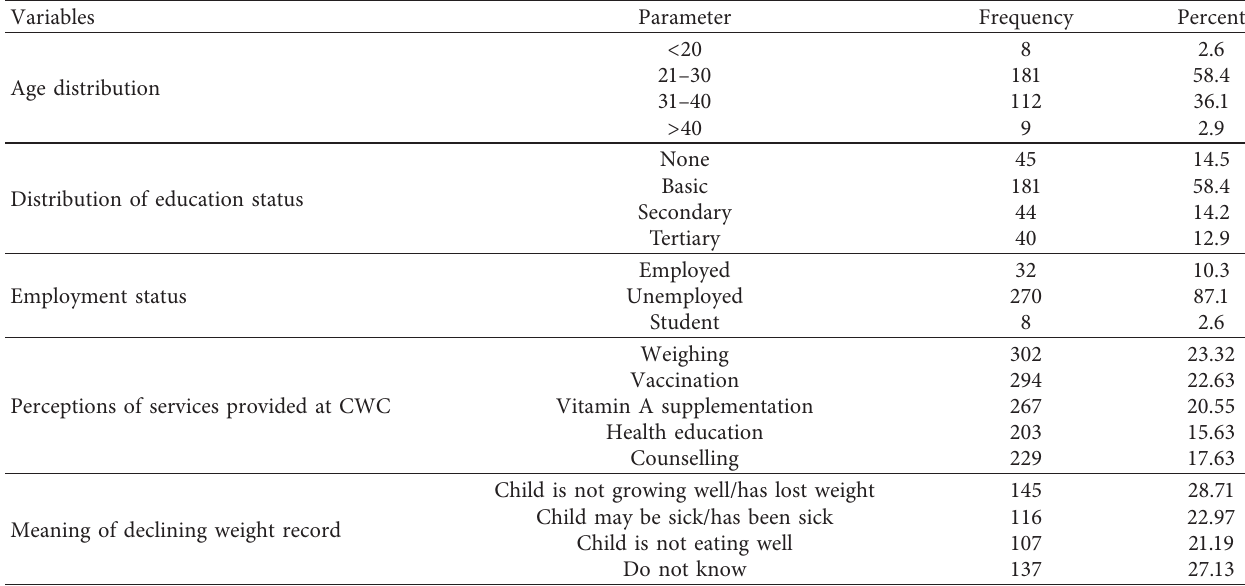
Table 1: Demographic characteristics and caregivers’ perception towards CWS.